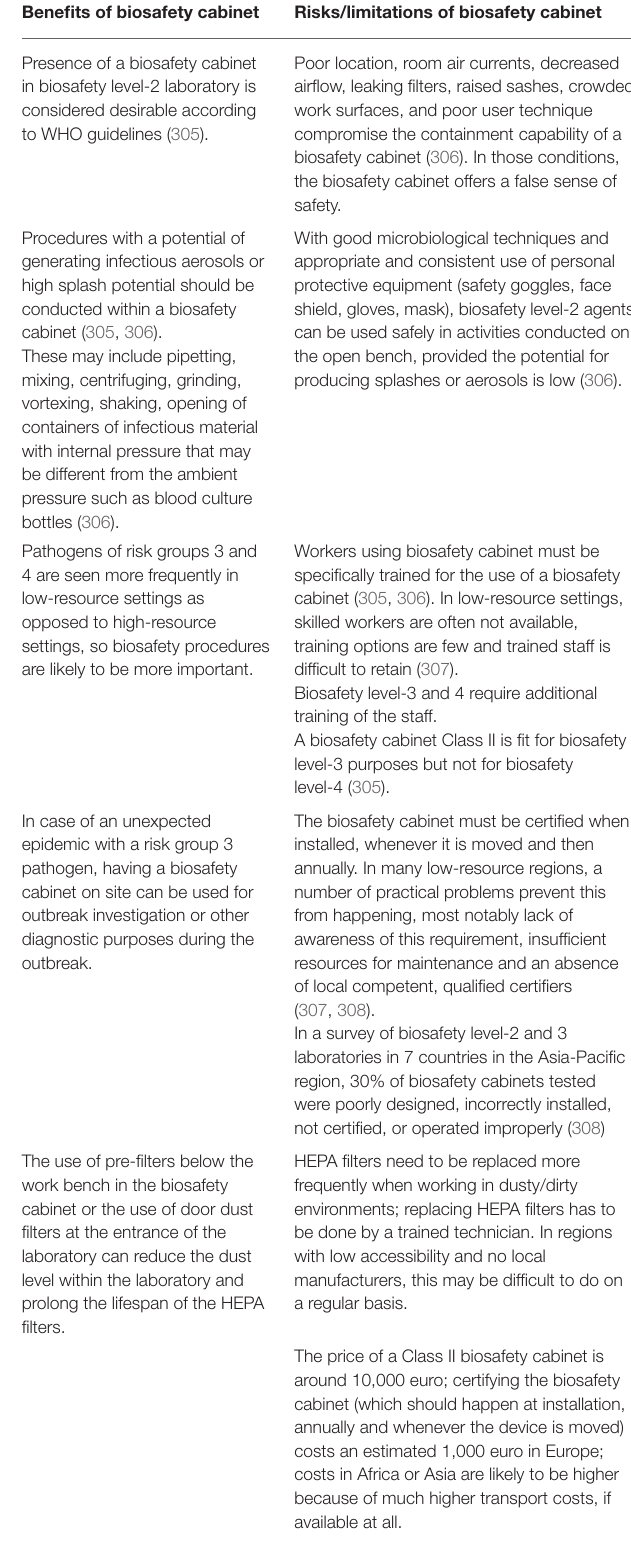
TABLE 7 | Benefits, risks and limitations of a biosafety cabinet in low-resource